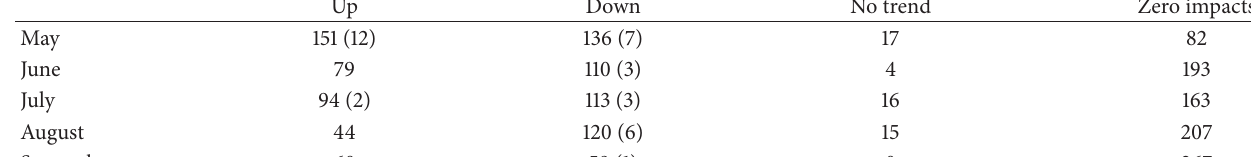
Table3:Numberofstationswithpositive,negative,andnotrends,alongwithnumberofstationswithoutimpacts(1990–2010).Inparentheses are numbers of stations with significant trend.